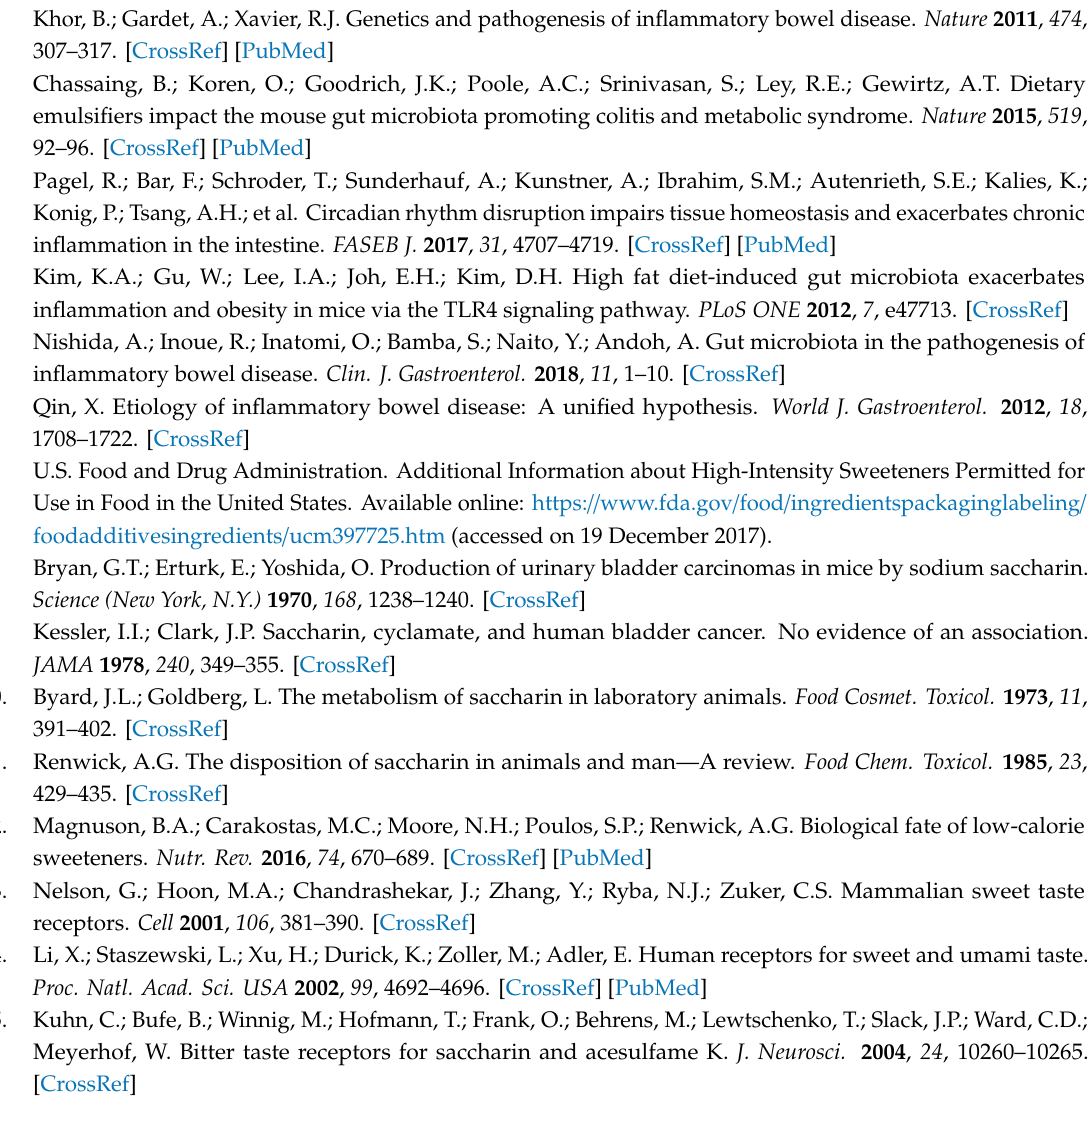
Figure S1: T1R2 and T1R3 expression in the murine intestine. Figure S2: Microbiome analysis, water consumption and weight development of saccharin-supplemented or ctrl